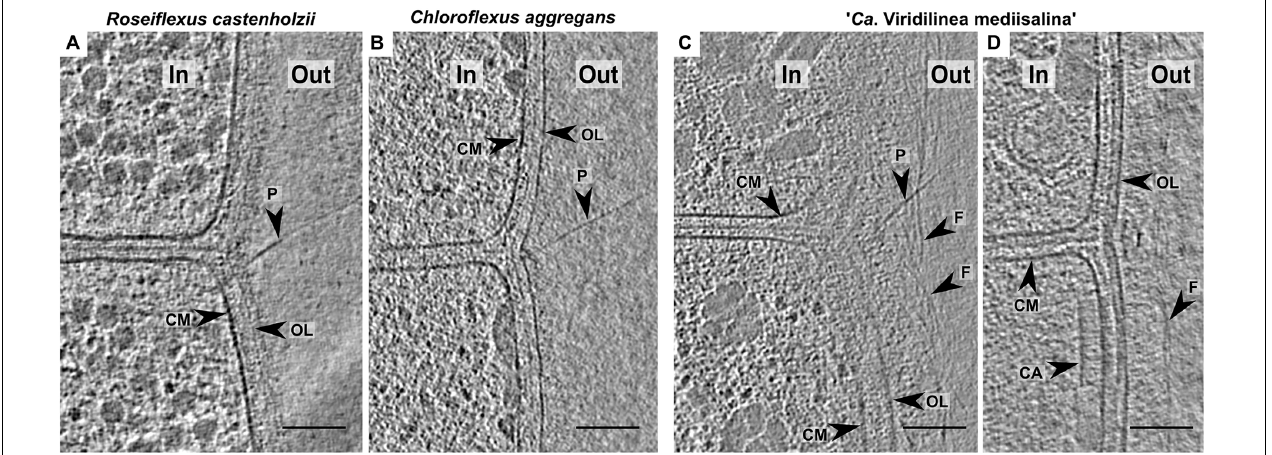
FIGURE 3 | Slices through tomograms of the cells in R. castenholzii (A) , C. aggregans (B) , “ Ca . Viridilinea mediisalina” (C,D) . In, cytoplasm in a cell; out, extracellular space; CM, cytoplasmic membrane; CA, chemoreceptor-like array; EL, external layer; F, fibrils; OL, outer layer; P, pilus. Bars: 100 nm.